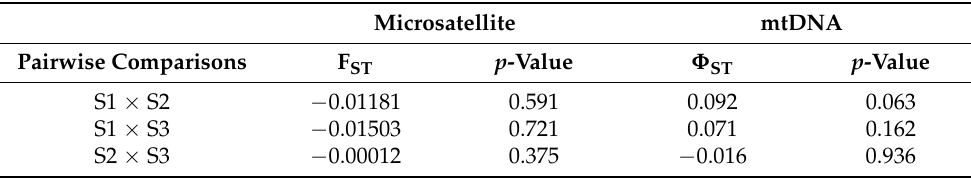
Table 2. Pairwise genetic differentiation between samples of Steindachneridion melanodermatum col- lected in the three sites of the Lower Iguaçu River. p ≤ 0.05 (significance test using 1010 permutations). Φ ST—parameter based on Wright’s F